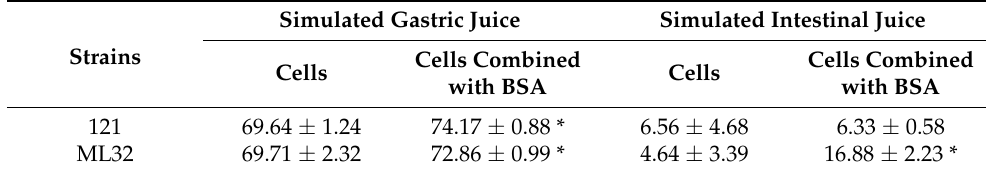
Table 2. The BaP-binding ability of Lactobacillus –BSA in the simulated gastrointestinal tract. Simulated Gastric Strains